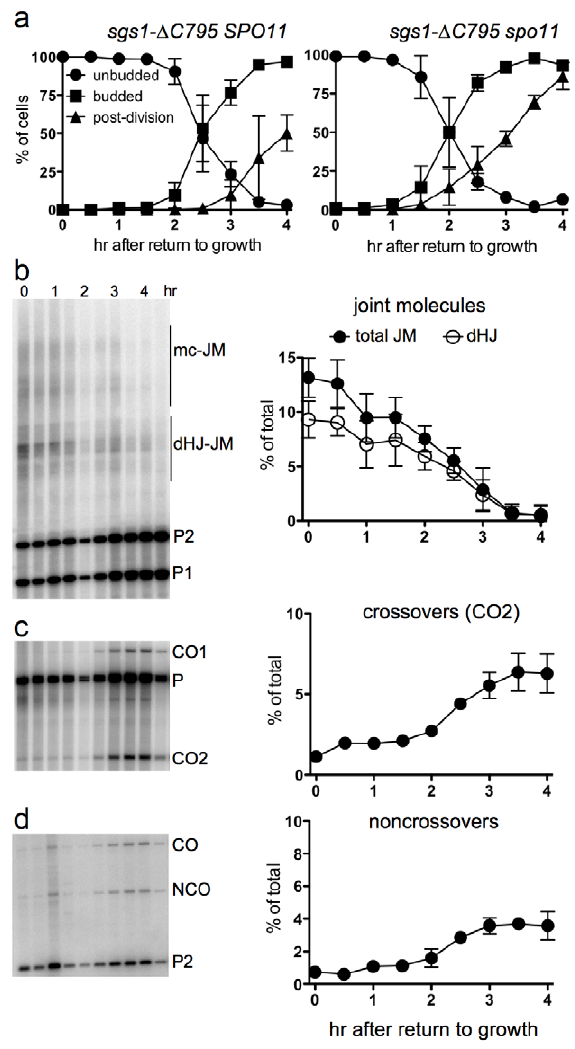
Figure 6. Delayed JM resolution and increased CO formation after RTG in the absence of the Sgs1 helicase. a. Delayed nuclear division during RTG of in the absence of Sgs1 helicase activity is due to meiotic recombination. Panels show cell cycle progression of ndt80 D sgs1- D C795 cells that are meiotic recombination competent ( SPO11 , left; MJL3388) or recombination null ( spo11 , right; MJL3428). b. Joint molecule intermediates. Left: blots of Xmn I digests probed with ARG4 sequences. Right: frequencies of total JMs (multichromatid JMs, mcJMs plus dHJ-JMs, filled circles) and of dHJ intermediates (dHJ; empty circles) plotted as a percentage of total lane signal. c. Crossovers. Left: blots of Xho I digests probed with ARG4 sequences. Right: CO product 2 (CO2) are plotted as a percentage of total lane signal. d. Noncrossovers. Left: blots of Xho I /Eco RI digests probed with HIS4 sequences. Right: NCOs, plotted as a percentage of total lane